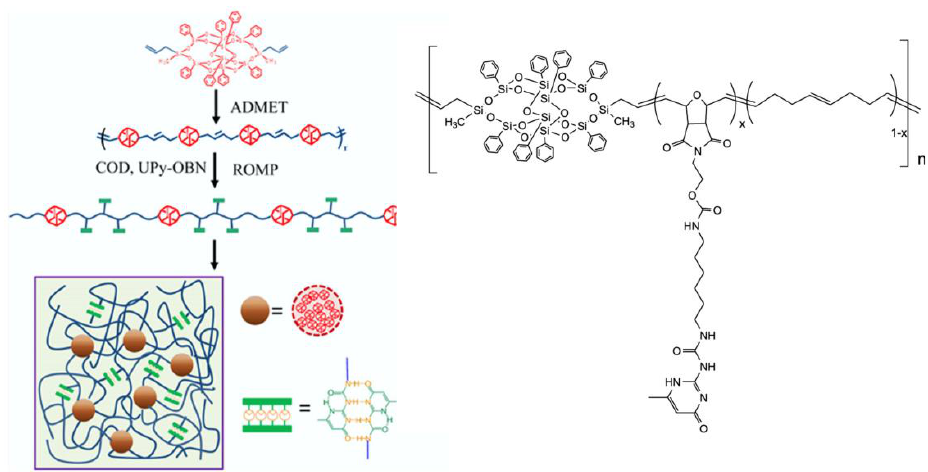
Figure 6. Synthesis of hybrid organic-inorganic P(DDSQ-COD-co-UPy) copolymers and illustration of DDSQ phase separation within the polymer matrix. Reprinted with permission from Macromolecules